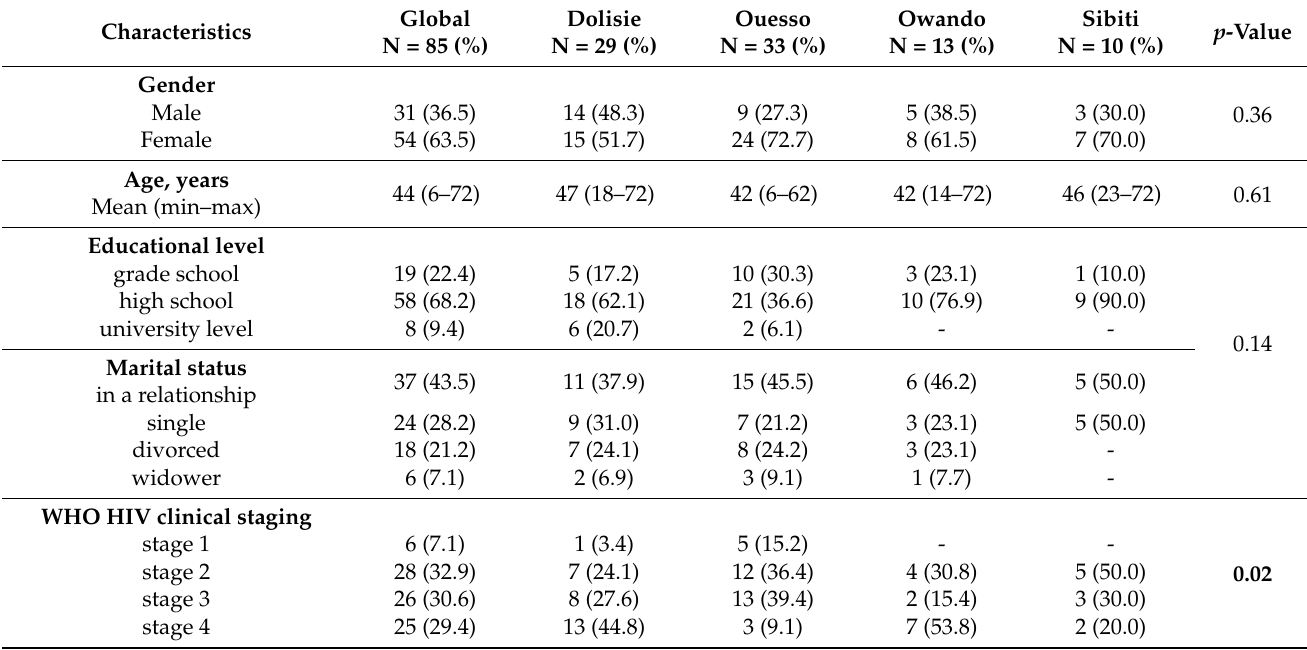
Table 1. Baseline characteristics (sociodemographic, clinical and biological) of the study population in general, and in their respective